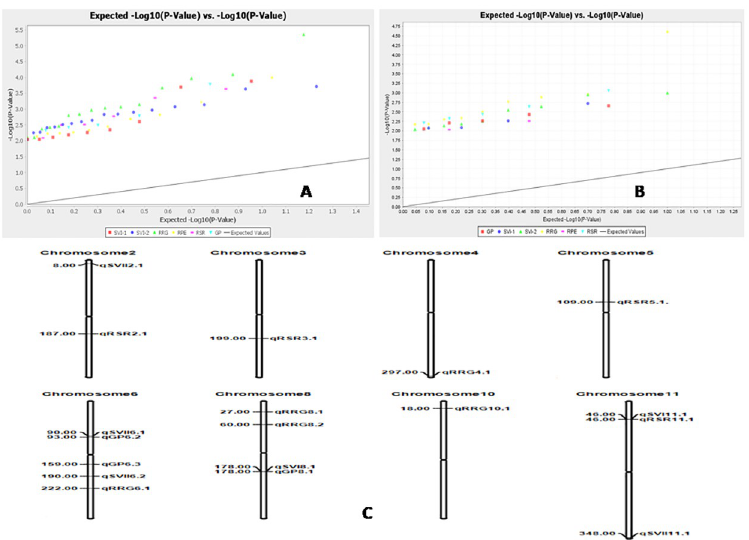
Fig 10. Distribution of marker-trait association and quantile–quantile (Q-Q) plot generated from Generalized Linear Model analysis for six antioxidant traits at (A) p < 0.05, (B) at p < 0.01 and (C) the positionsof the QTLs on the chromosomes for RSG, RGR, AGR and MGR detected byassociation mapping